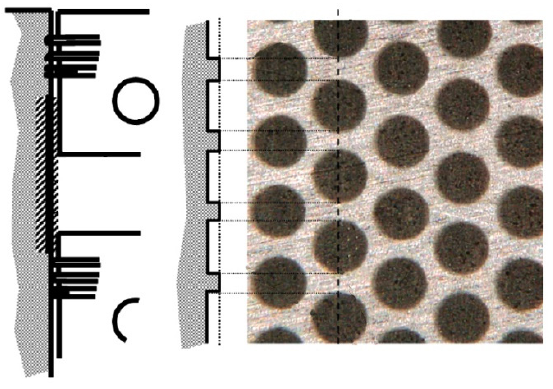
Figure 14. Scheme of surface texturing, after [105].